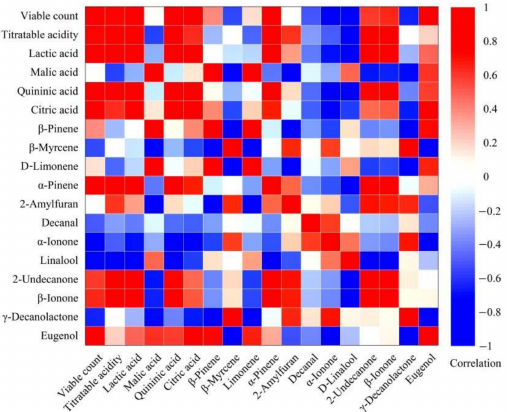
Figure 4. Heat map of Pearson correlation coefficient for variables. The correlations among fermenta- tion time, viable count in juice, total acid and organic acid contents, and aroma-active compounds are shown. The larger the positive number, the stronger the positive correlation, and the opposite for negative correlation.